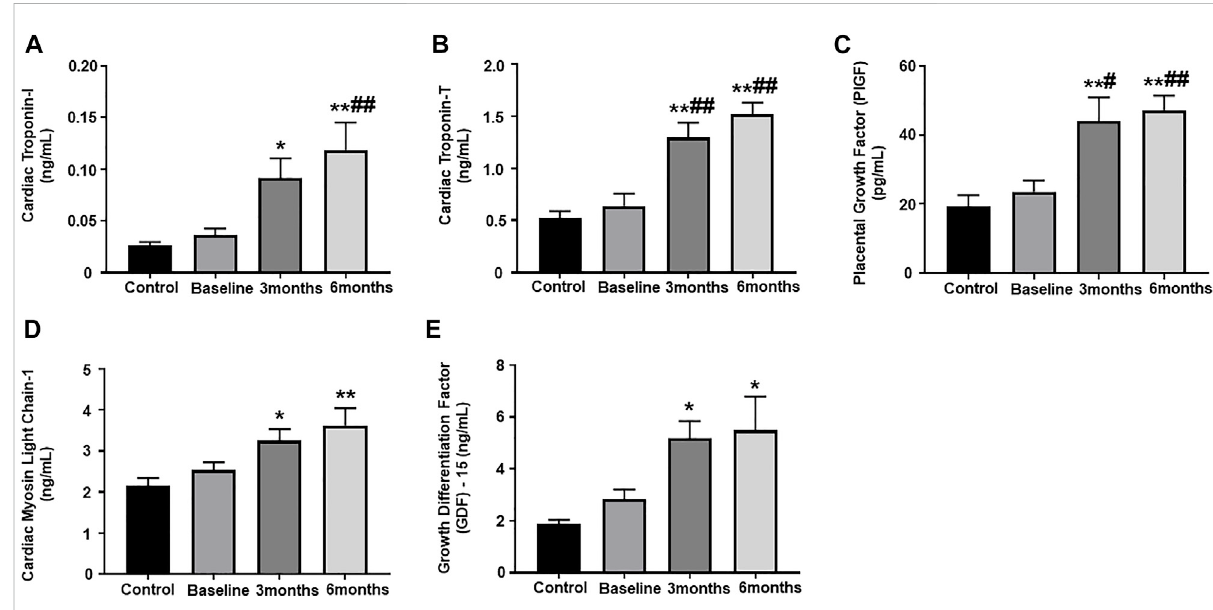
FIGURE 1 Assessment of plasma biomarkers. Quantitative analysis of plasma biomarker concentrations by ELISA: (A) cardiac troponin I, (B) cardiac troponinT, (C) placentalgrowthfactor(PIGF), (D) cardiacmyosinlightchain1(cMLC1), (E) growthdifferentiationfactor15(GDF-15).Valuesrepresent means ± SEM. * p < 0.05 vs. Control, ** p < 0.01 vs. Control, # p < 0.05 vs. Baseline, ## p < 0.01 vs. Baseline.